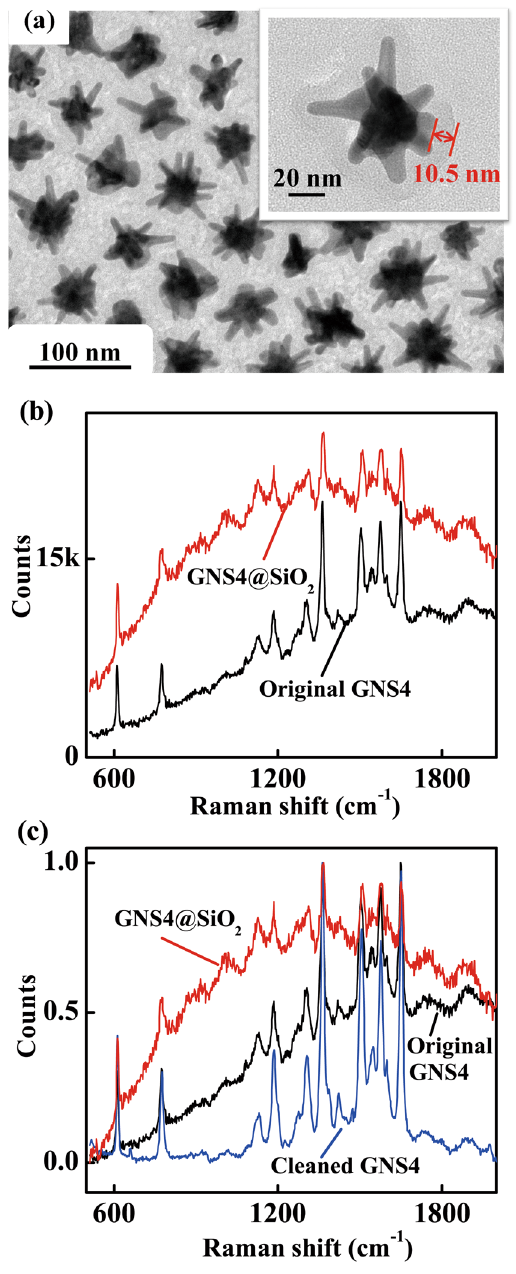
Figure 7. ( a ) TEM micrograph of the GNS4@SiO 2 (inset: higher magnification TEM image for individual GNS4@SiO probes. ( c ) normalized Raman spectra of the GNS4@SiO 2 (red line), original GNS4 (blue line), and cleaned GNS4 (black